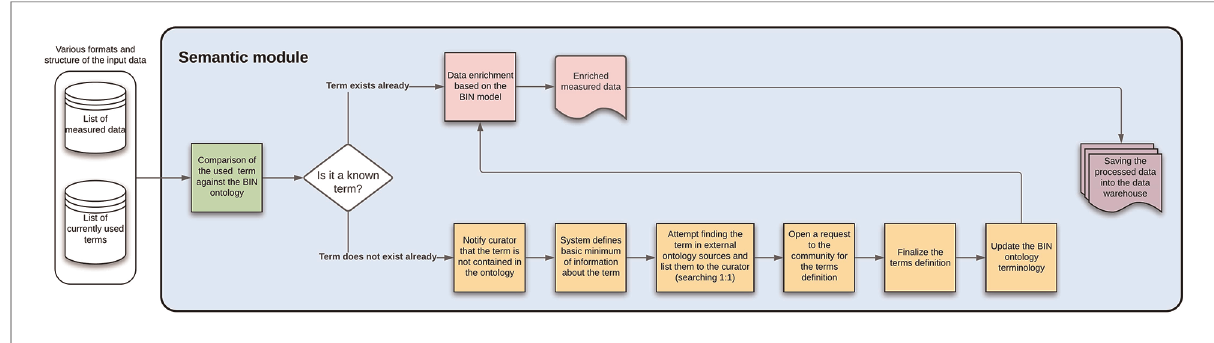
FIGURE 11 Semantic module — the fi gure describes each of the steps that will be done automatically by the module, showing also the process inputs and